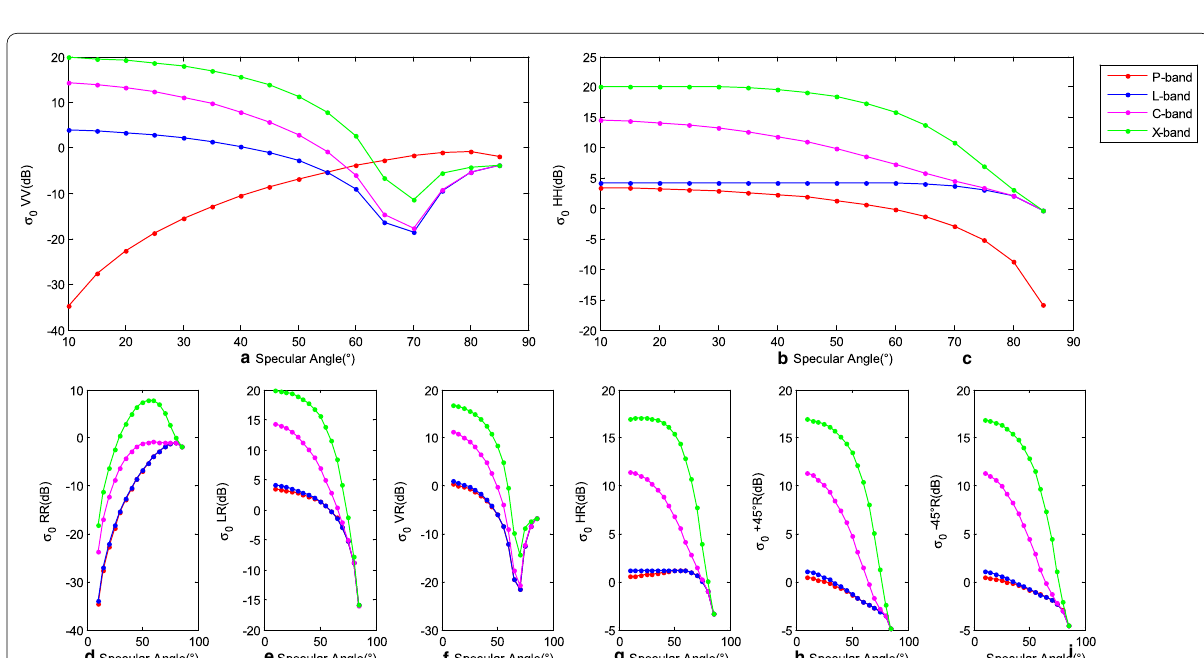
Fig. 8 Various polarizations random rough surface scattering cross section versus scattering angle for P-, L-, C- and X-band at specular